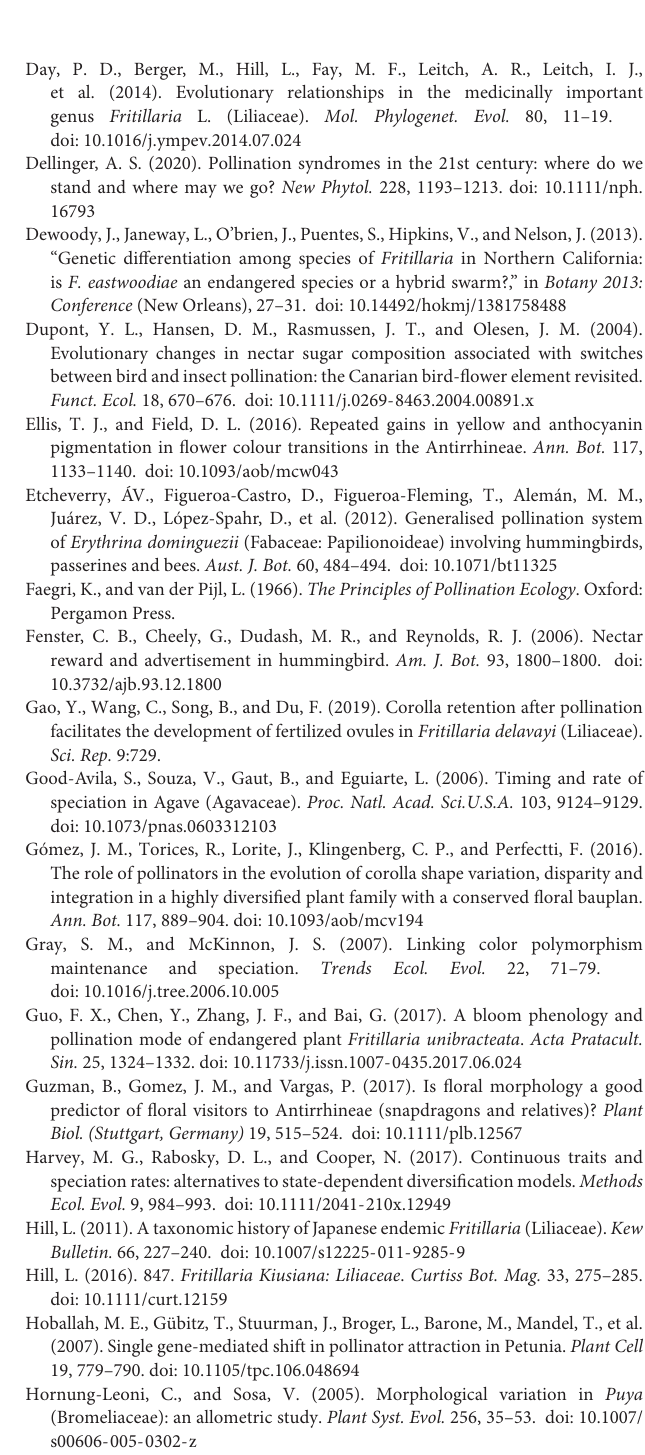
Supplementary Material 1 | Table with accession numbers of the used DNA regions: ( matK , rpl16, and rbcL ), nuclear (18S) and internal transcribed spacer (ITS). Supplementary Material 2 | The description of the methods used for DNA extraction, amplification, and sequencing of matK regions for F. biflora and F. olgae